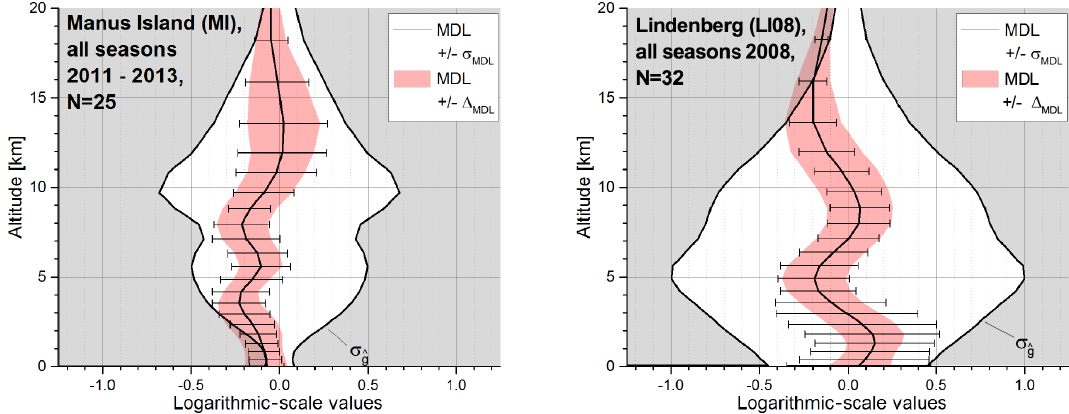
Figure 11. Vertical profiles of retrieval skill scores calculated according to Eqs. (16)–(19) for the MI and LI08 ensembles. The black line and error bars represent the mean difference and the 1 σ scatter between IASI and smoothed GRUAN data (MDL and ± σ MDL ). The red shaded area around MDL is the 1 σ scatter expected due to MUSICA IASI and GRUAN errors ( ± (cid:49) MDL ). The grey shaded area represents the area beyond the 1 σ variability of smoothed GRUAN data (area beyond ± σ ˆ g